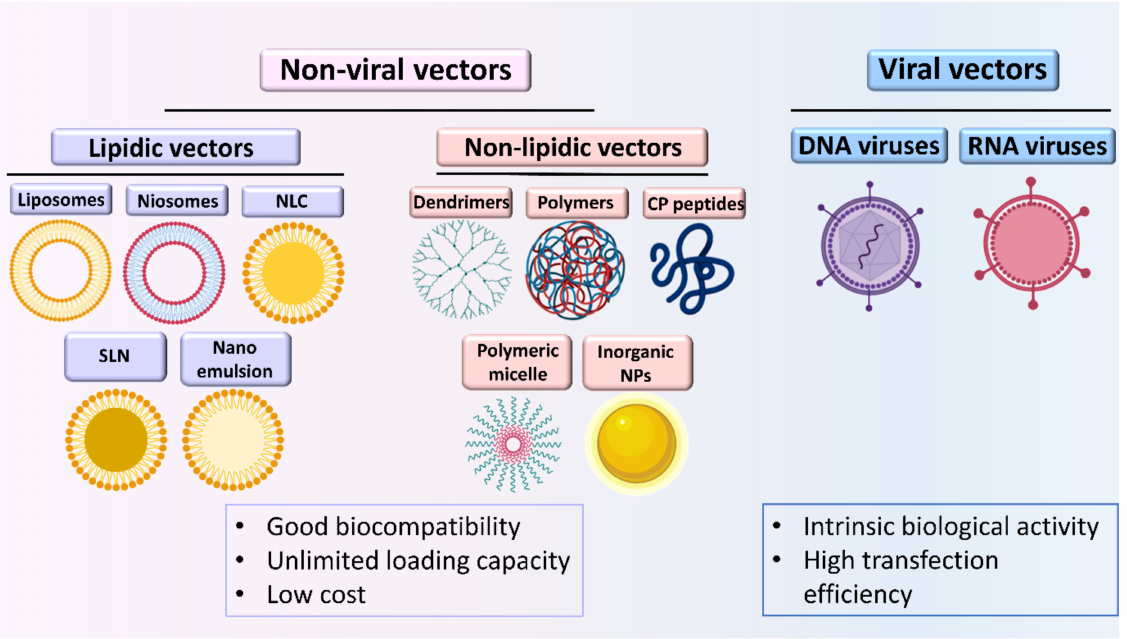
Figure 1. Viral and non-viral carriers of nucleic acids. NLC: nanostructured lipid carrier, SLN: solid lipid nanoparticles, CP: cell penetrating, NPs: